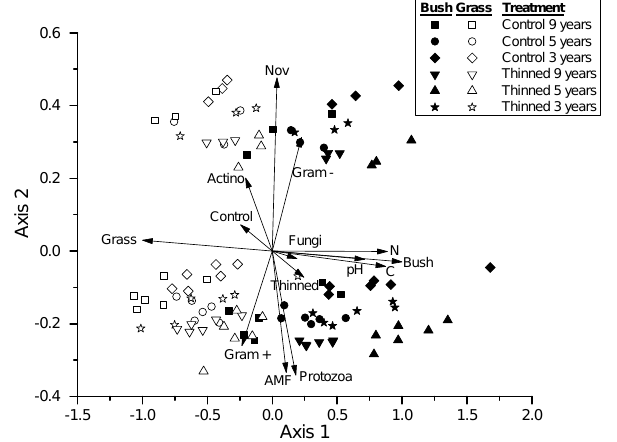
Figure 3. Redundancy analysis of soil PLFA. Vectors indicate the correlations between each factor and the axes. Very small vectors were eliminated for the sake of